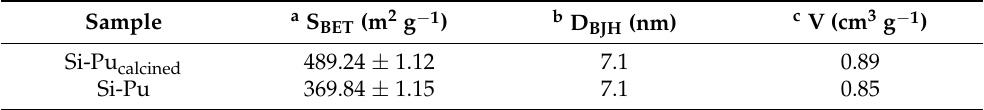
Table 1. Results of the nitrogen adsorption for the organofunctionalized material before and after